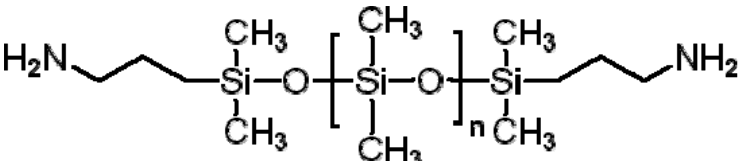
Figure 11. Structural formula of polydimethylsiloxane.